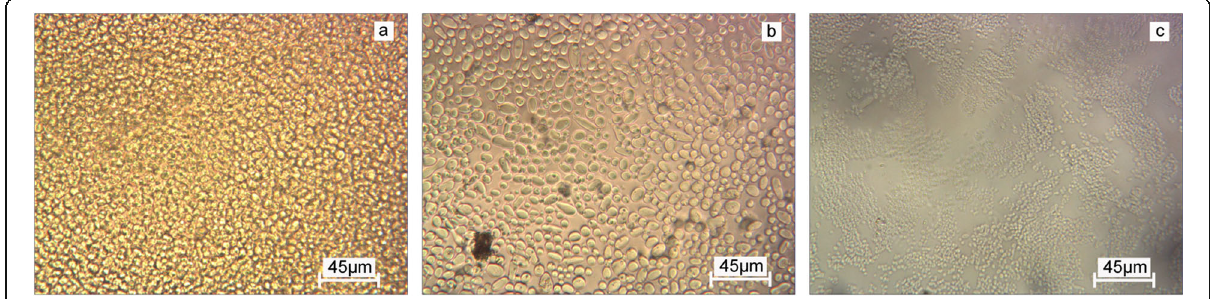
Fig. 4 The morphology of microcapsules at different pH values with the gelatin/CMC ratio of 9:1. a pH= 4.54, b pH= 4.71, c pH= 4.76. When the ratio of gelatin/CMC was 9:1, the pH range for the formation of spherical microcapsules was 4.54 to 4.71, and its particle size decreased while lowering the pH